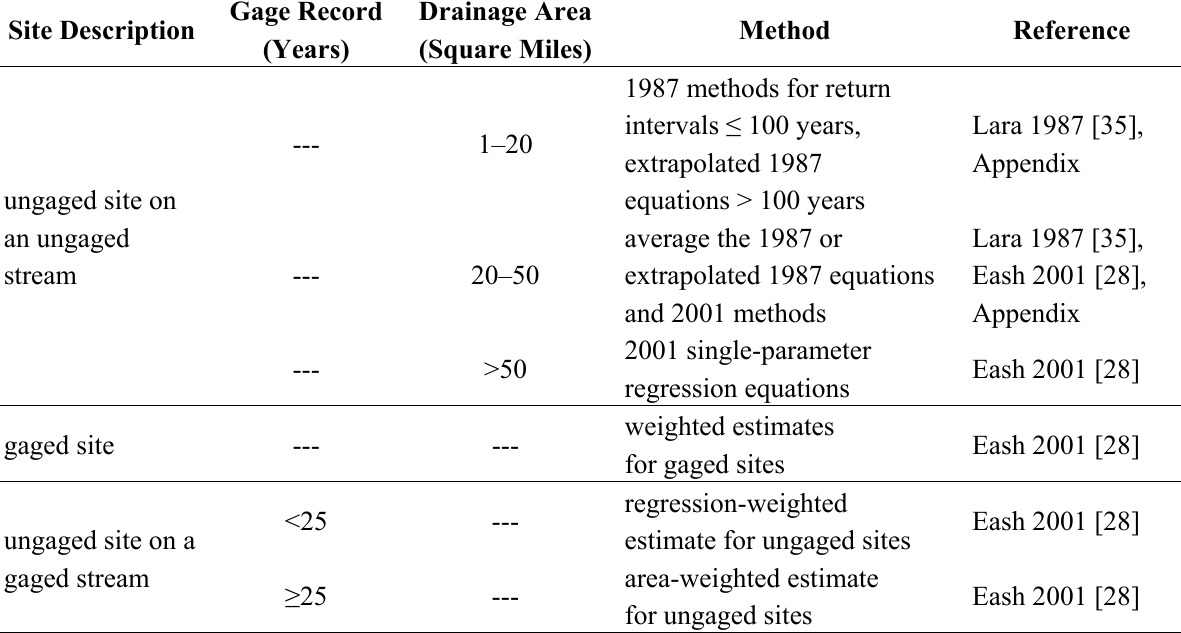
Table 1. Summary of methods used to estimate annual exceedance